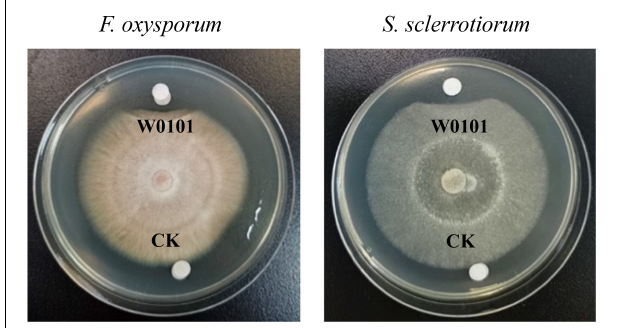
FIGURE 1 | The antifungal activity of the strain W0101 against Fusarium oxysporum and Sclerotinia sclerotiorum . W0101, culture supernatant of W0101; CK, LB medium as control.